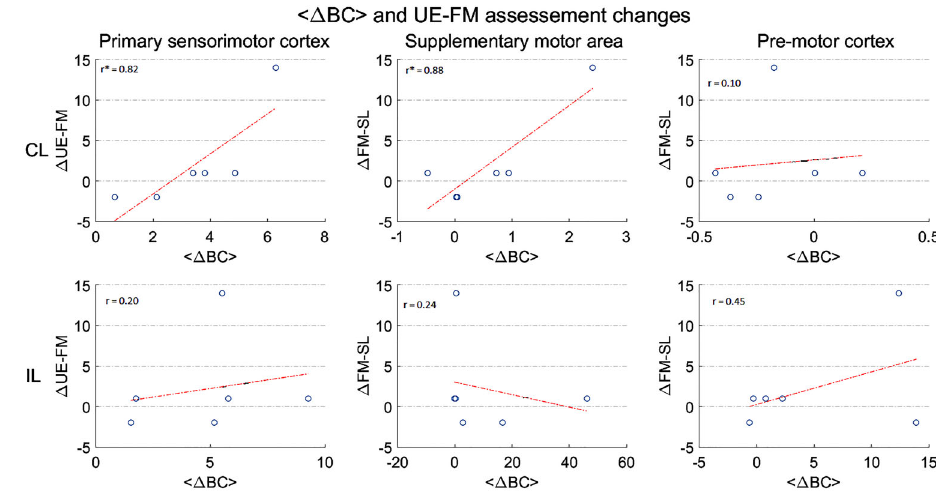
Figure 5. Relationship between upper-extremity Fugl-Meyer (UE-FM) scale changes and average betweenness centrality (BC) variation for the motor stroke group. In this plot, each point corresponds to the o D BC 4 and D UE-FM values of a subject. Plots in the upper and lower panels correspond to the contralesional (CL) and ipsilesional (IL) hemispheres, respectively. Each column designates o D BC 4 values gathered at speci fi c areas. The correlation strength between the two variables, i.e., the o D BC 4 and the corresponding changes in UE-FM (indicated by D UE-FM), are shown as r, that indicates the value of the correlation coef fi cient. When the P corresponding to that rho is less than 0.05, the correlation is signi fi cant. The correlation strength between the two variables is shown with an asterisk (*) when signi fi cant (P o